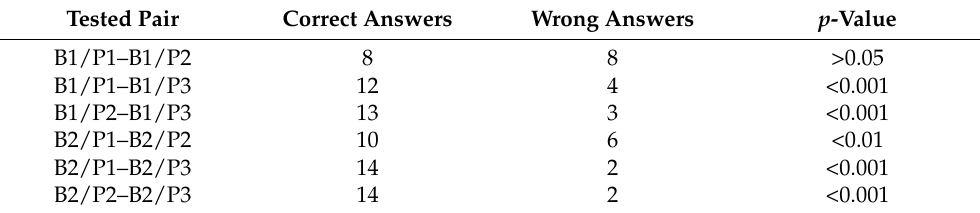
Table 2. Triangle tests to determine sensory differences in beer after 9 months of natural aging ( n = 16) (B1: barley variety 1; B2: barley variety 2; P1: low proteolytic malt modification; P2: medium proteolytic malt modification; P3: high proteolytic malt